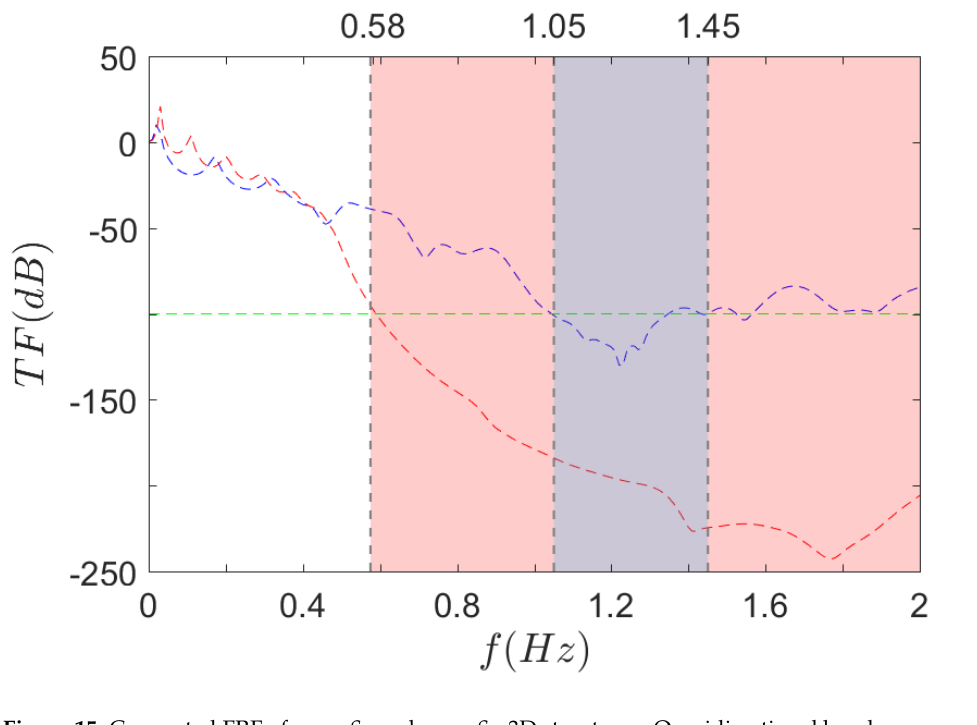
Figure 15. Computed FRF of S 0 and S R 3D structures. Omnidirectional bandgap ranges under 2 kHz for S 0 and S R , as found in the dispersion